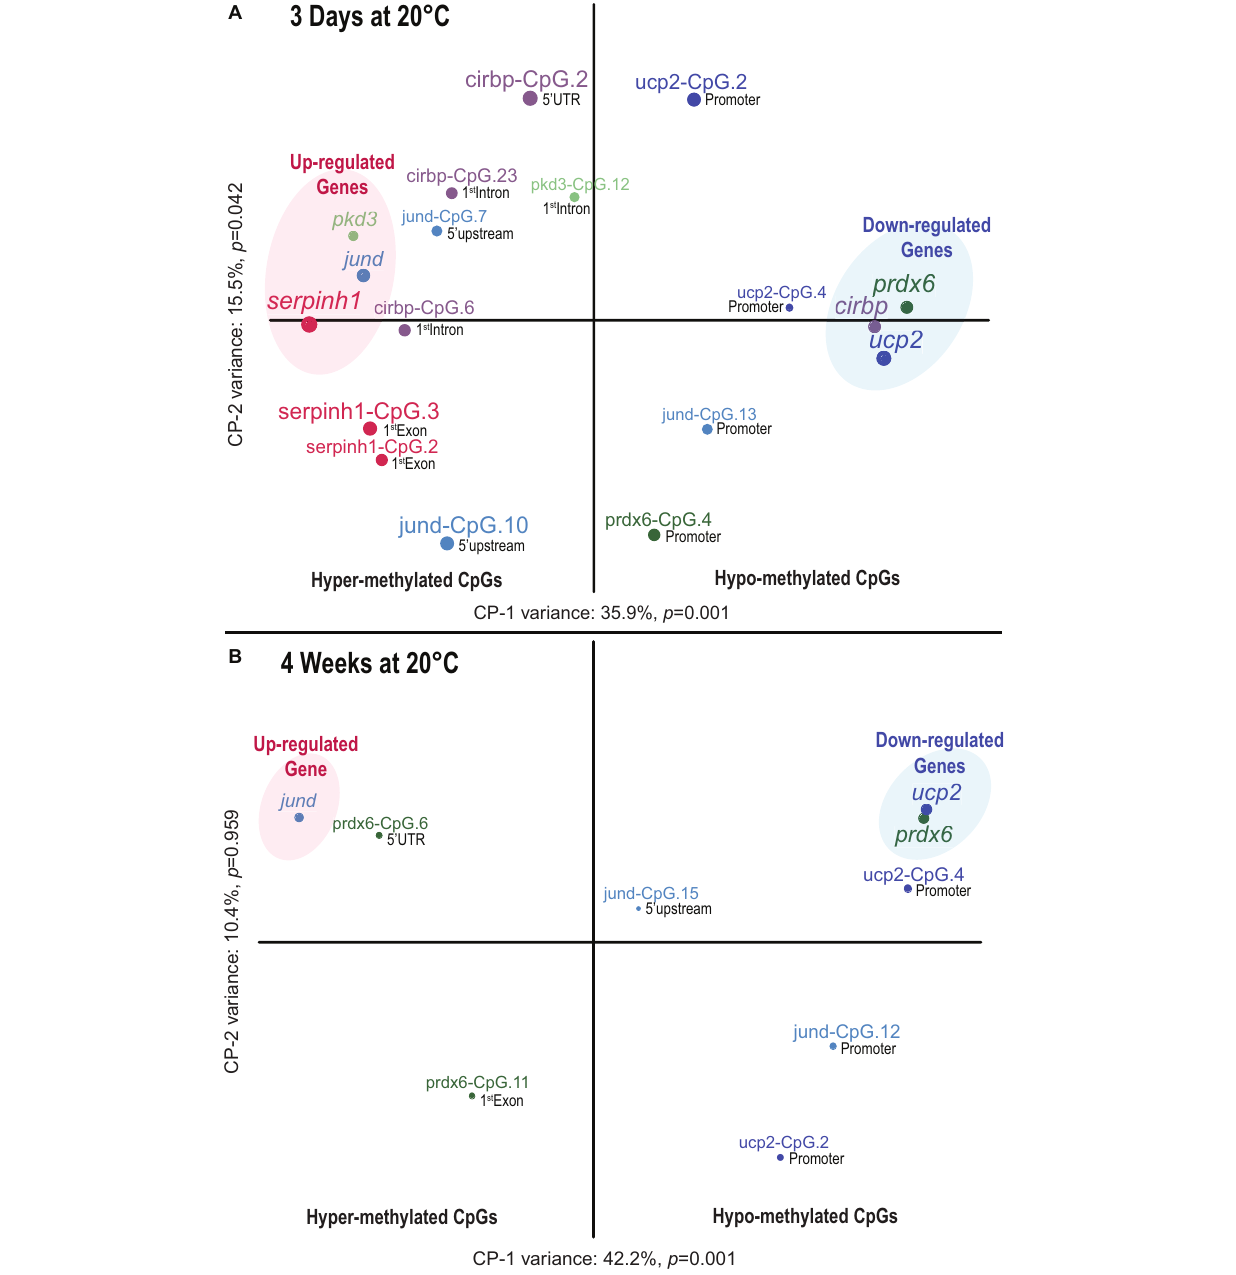
FIGURE 6 | Time dependent association between CpG methylation and transcript expression in Atlantic salmon exposed to high temperature and hypoxia. (A) Component map based on 12 significantly affected CpGs and the transcript expression of six genes ( serpinh1 , jund , pdk3 cirbp , prdx6 , and ucp2 ) in the liver of Atlantic salmon challenged for 3 days to 20 ◦ C with and without hypoxia ( ∼ 70% air saturation). (B) Component map based on six significantly affected CpGs and the corresponding transcript expression for three genes ( jund , prdx6 , and ucp2 ) in the liver of Atlantic salmon challenged for 4 weeks to 20 ◦ C with and without hypoxia ( ∼ 70% air saturation) ( n = 8 per treatment/time point, N = 48 total). Each component map illustrates the relationship between CpG methylation and the transcript expression response. The results of the battery of inference permutation test indicate which components are significantly affected ( p < 0.05). The circle and label size correspond with the magnitude of the component scores obtained for each response variable, and the label color associates CpGs with corresponding genes. The terms hyper- and hypo-methylation relate to the direction of the respective CpG methylation response (see Table 2 ). The genomic location (promoter, 5 (cid:48) upstream, 5 (cid:48) UTR, first coding exon and first intron) of each CpG is indicated next to the circles (see Figure 2 ). The CpGs indicated by “promoter” were located close to (i.e., within < 25 bp) or within the putative promoter motif (TATA-box, POL-II promoter sequence) (see Figure 2 ). The transcript expression data for the six genes ( serpinh1 , jund , pdk3 , cirbp , prdx6 , and ucp2 ) from the short-term exposure time point (3 days at 20 ◦ C) were previously published as part of an initial transcriptome study by Beemelmanns et al. (2020), and were included herein to specifically investigate the correlation between transcript expression and DNA methylation